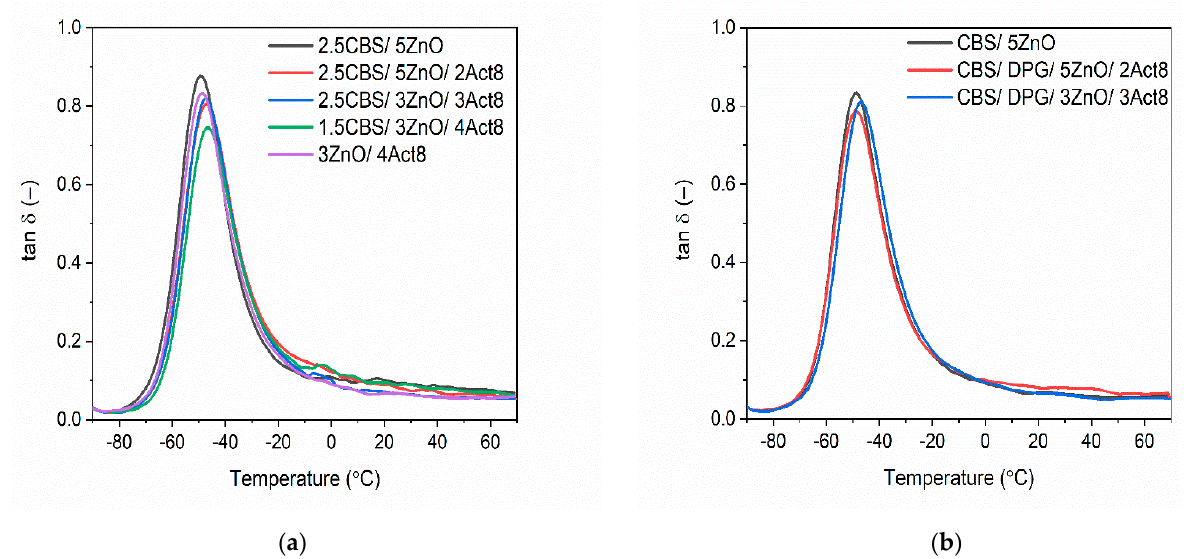
Figure 4. Mechanical loss factor (tan δ ) curves versus temperature of SBR vulcanizates containing: ( a ) CBS; ( b ) CBS and DPG. Table 5. Glass transition temperature (T g ) and mechanical loss factor (tan δ ) of SBR vulcanizates.